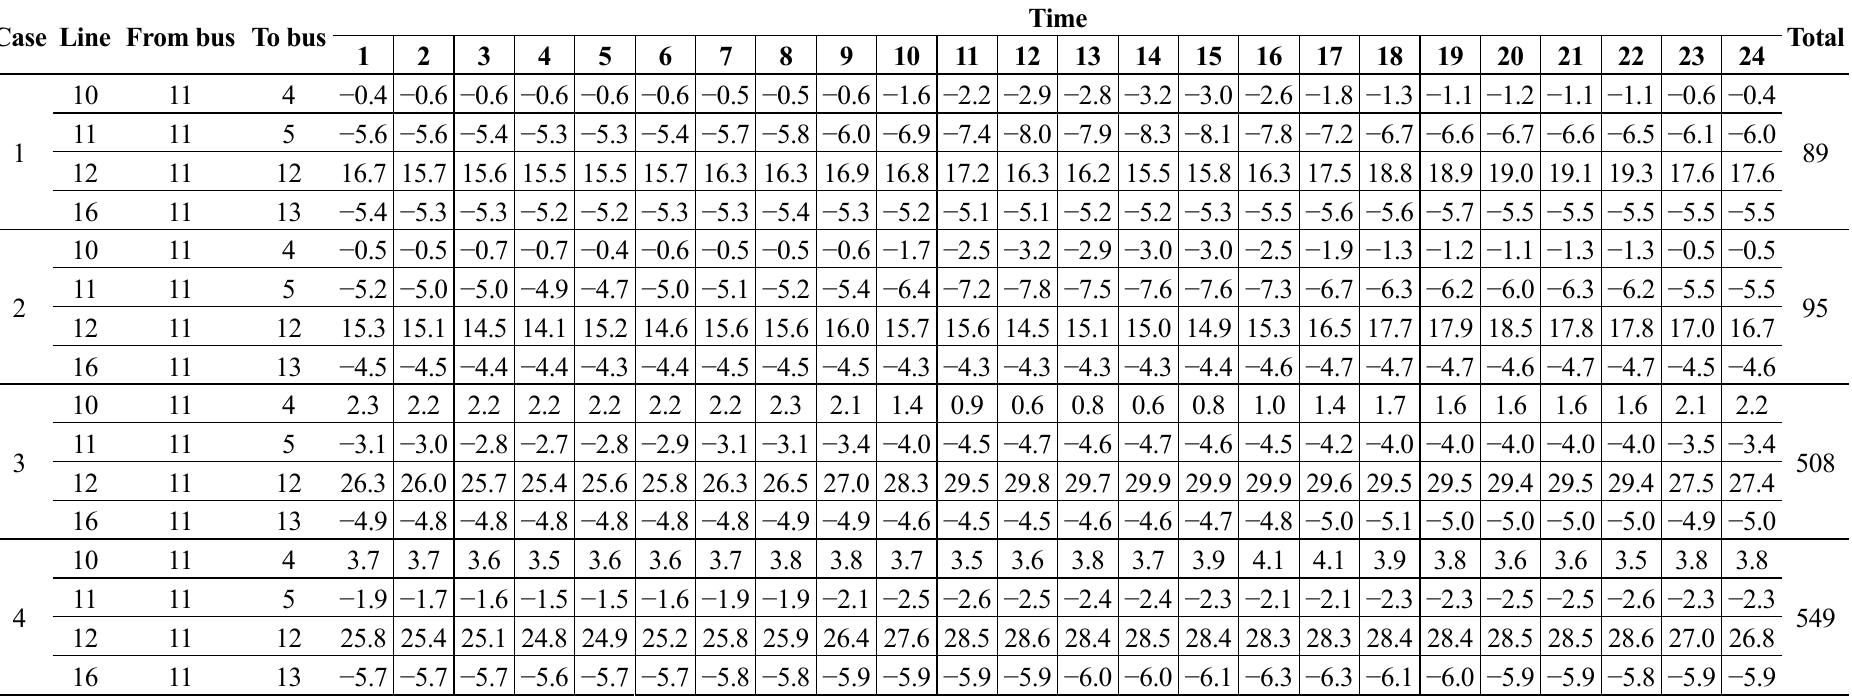
Table 4. Reactive power flow on lines connecting to wind